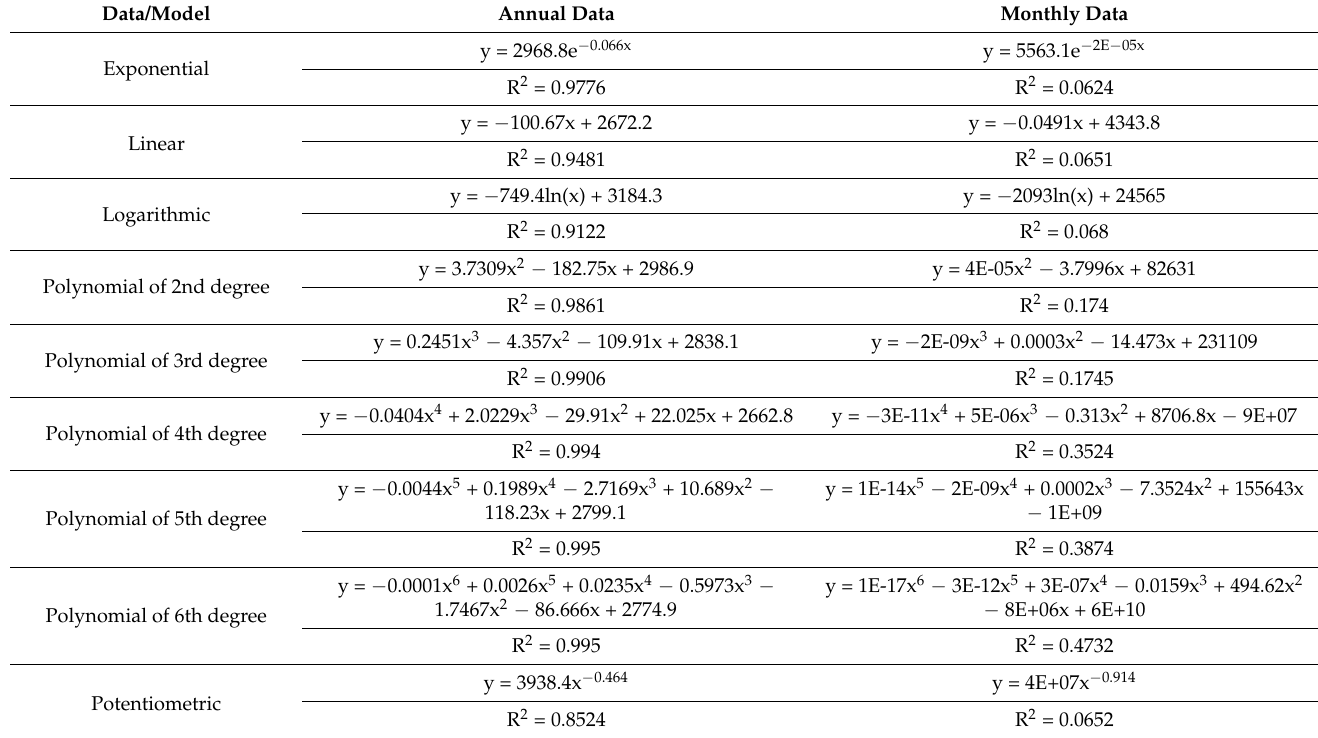
Table A2. Trend models for the Kuyavian–Pomeranian province.